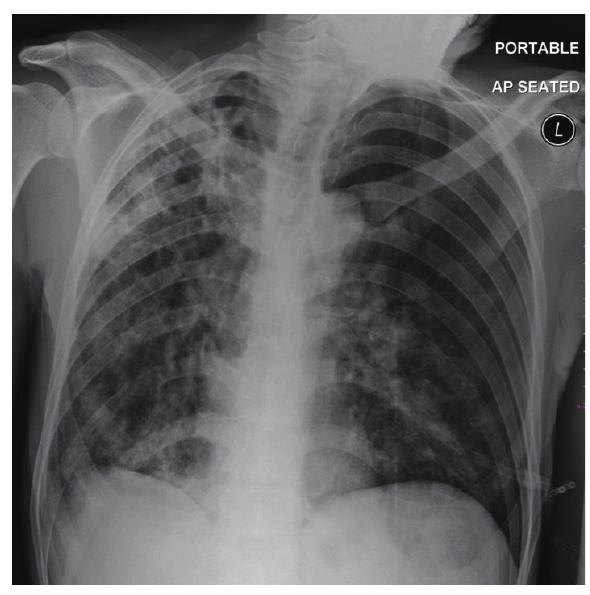
FIGURE 5: A 27-year-old male admitted to an isolation ward with COVID-19 pneumonia. Portable chest radiograph shows fibrosis and cavitation in the apical segment of the right upper lobe. Further bilateral right lung and left lingular air space opacities are noted. Brixia score: